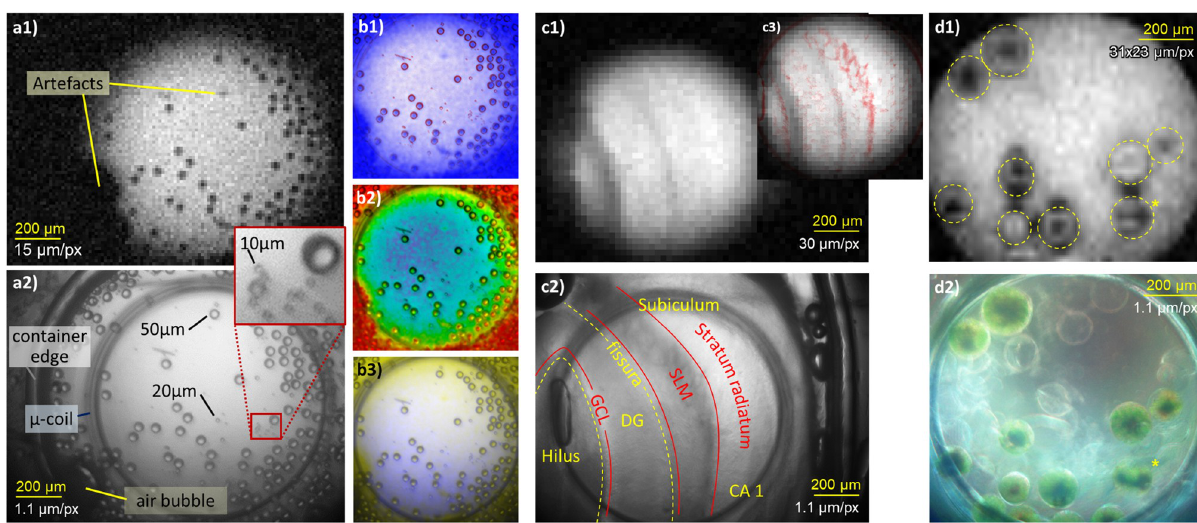
Fig 7. Left: MR (a1) and optical (a2) images of polymer beads suspended in water; contrast enhancement (b1), MR color coding (b2) and color addition combinations (b3). Center: MR (c1) and optical (c2) images of the hippocampus of a mouse; contrast enhancement image (c3, blue—optical, black—MR). DG—dentate gyrus, GCL—granule cell layer, SLM—stratum lacunosum-moleculare. Right: MR (d1) and optical (d2, dark field, reconctructed color) images of eremosphaera viridis , ( � ) likely formation of autospores.